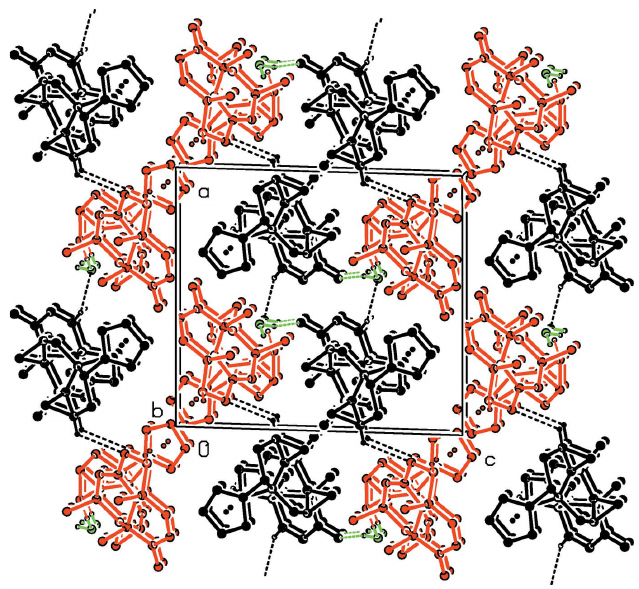
Figure 3 A view along the b axis of the crystal packing of the title compound. The hydrogen bonds are shown as dashed lines (see Table 1; colour code: black = molecule 1, red = molecule 2, green = water molecule). For clarity, only the H atoms involved in hydrogen bonding have been included.